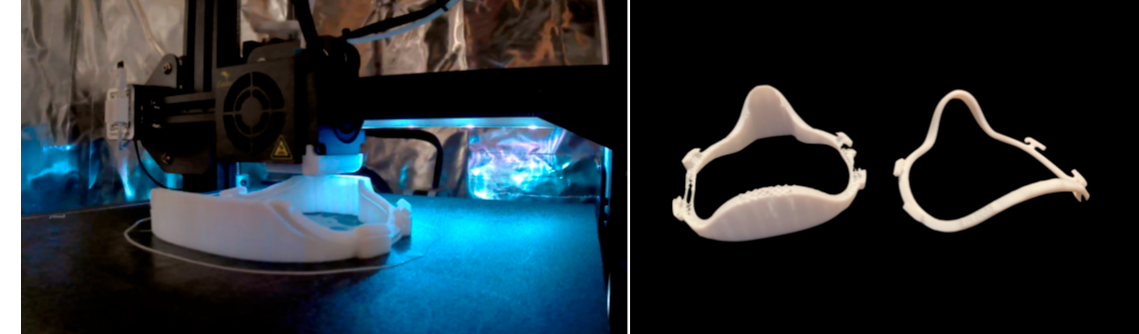
Figure 3. A GCode is generated by a 3D-printing slicing software (Ultimaker Cura).